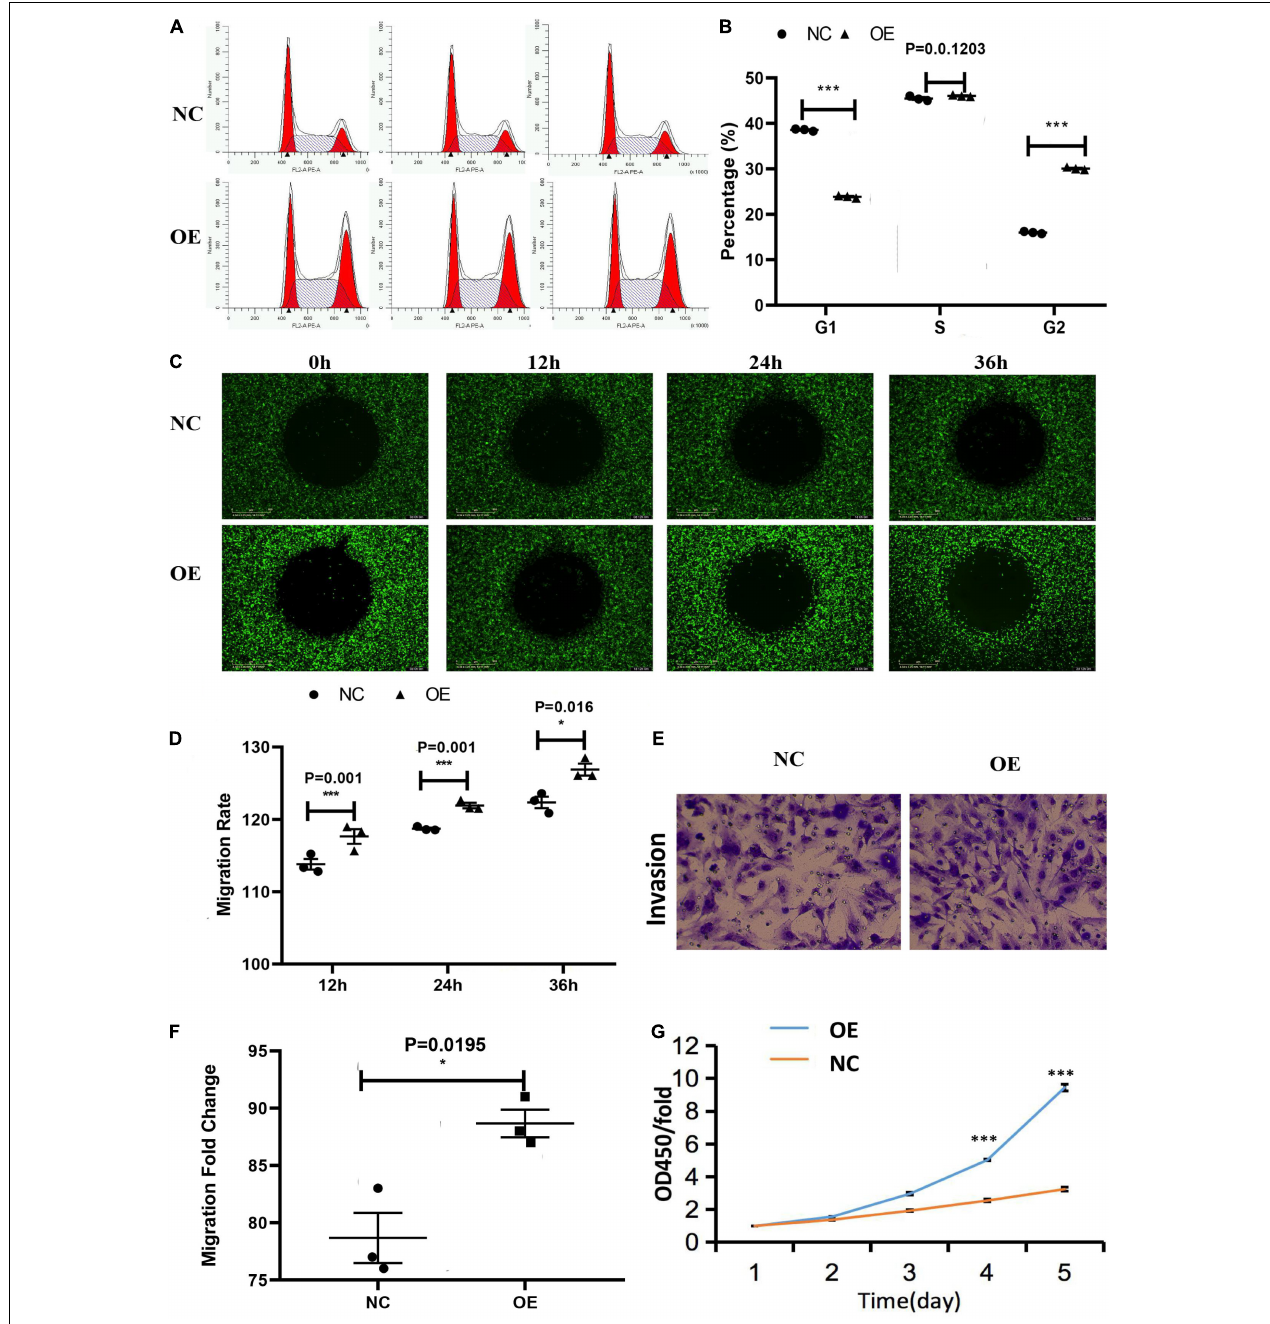
FIGURE 4 | Effect of the overexpression of ACTA2 on the migration and invasion ability of HMEC-1. (A,B) Cell cycle distribution was determined by flow cytometry after propidium iodide (PI) staining. (C,D) Oris TM plate Wound-healing assay for the migration of HMEC1 after ACTA2 overexpressing. (E,F) Invasion assay for the invasion of HMEC1 after ACTA2 overexpressing. (G) CCK-8 assay for the proliferation of HMEC1 after ACTA2 overexpressing. * P < 0.05, ** P < 0.01, *** P < 0.0001.